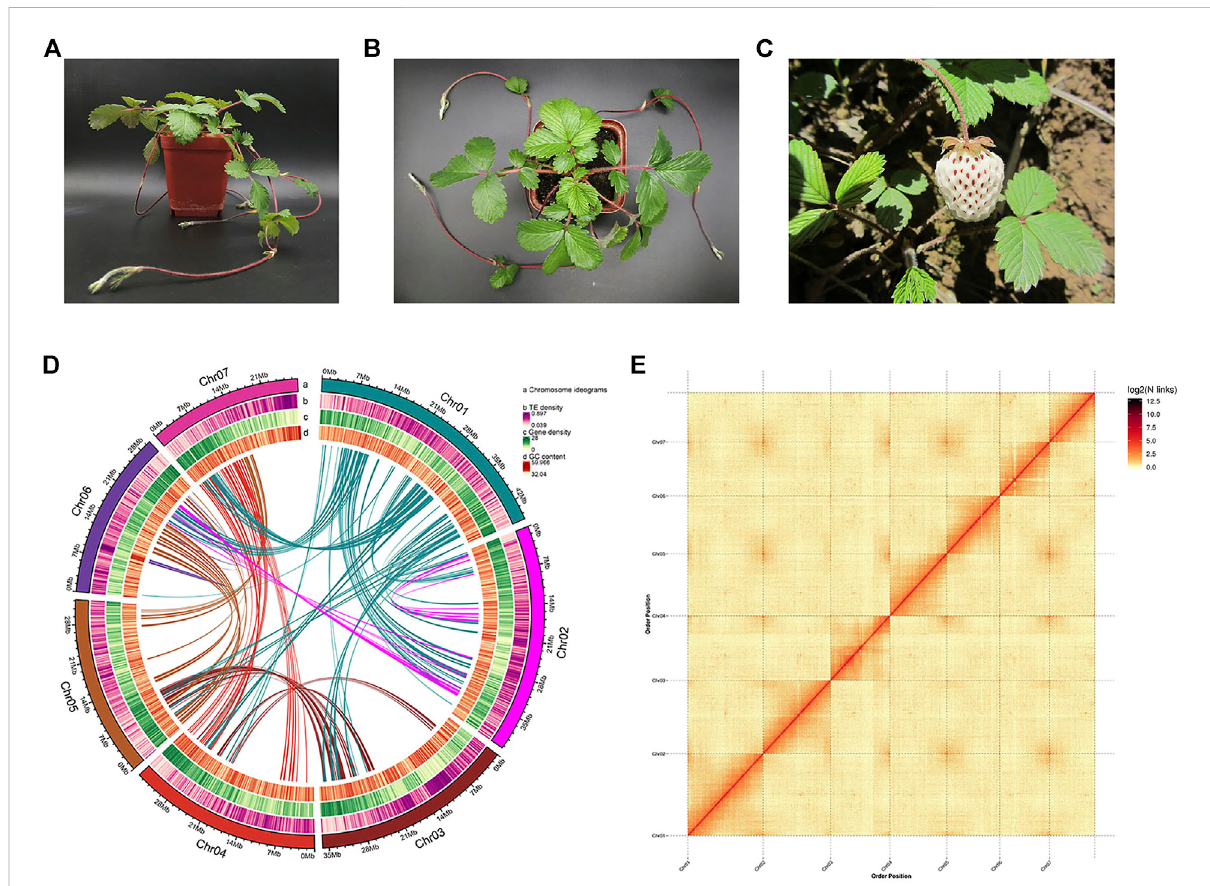
FIGURE 1 Genome assembly of Fragaria pentaphylla -FP039. (A,B) : Pictures of Fragaria pentaphylla -FP039 plant grown in the laboratory. (C) Pictures of Fragaria pentaphylla -FP039 plant grown in the wild where it was collected. (D) Circos plot of chromosome-level scaffolds showing the genomic features. Tracks from outside to the inner correspond to a, chromosome ideograms; b, TE (transposable elements) density; c, gene density; d, GC content. (E) Hi-C interaction heatmap showing interactions among seven chromosomes (the color bar on the right showing the interaction